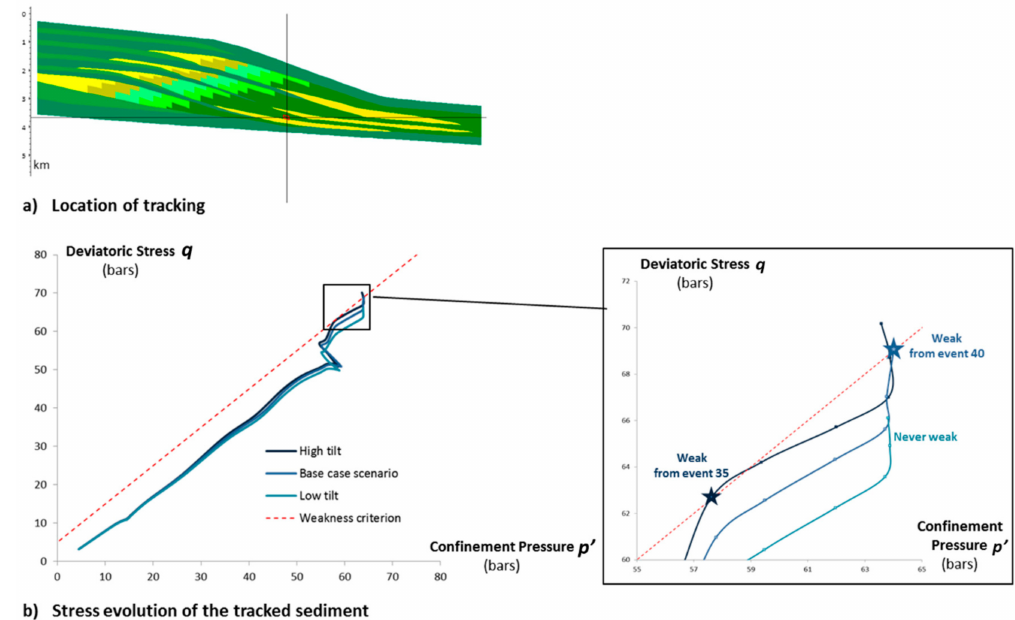
Figure 10. Influence of subsidence tilt on weakness development: locally. ( a ) location of the cell whose mechanical state was tracked through time; ( b ) evolution of the tracked cell in the p (cid:48) – q system for the three scenarios. The upmost curve corresponds to the high tilt scenario and the downmost curve to the low tilt scenario. The weakness criterion is reached earlier in the high tilt scenario due to higher shear resulting in higher deviatoric